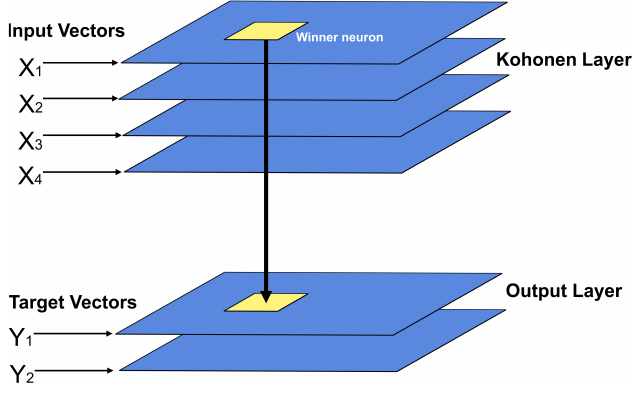
Figure 6. Counterpropagation Artificial Neural Network